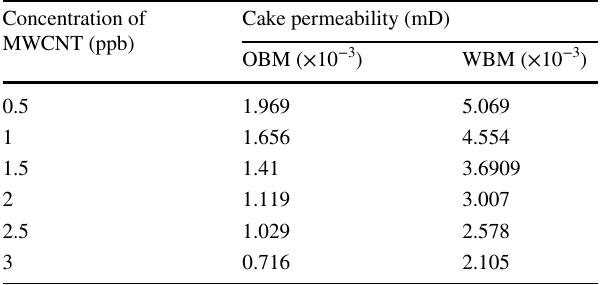
Table 6 Cake permeability for WBM and OBM formulated with MWCNT Concentration of MWCNT